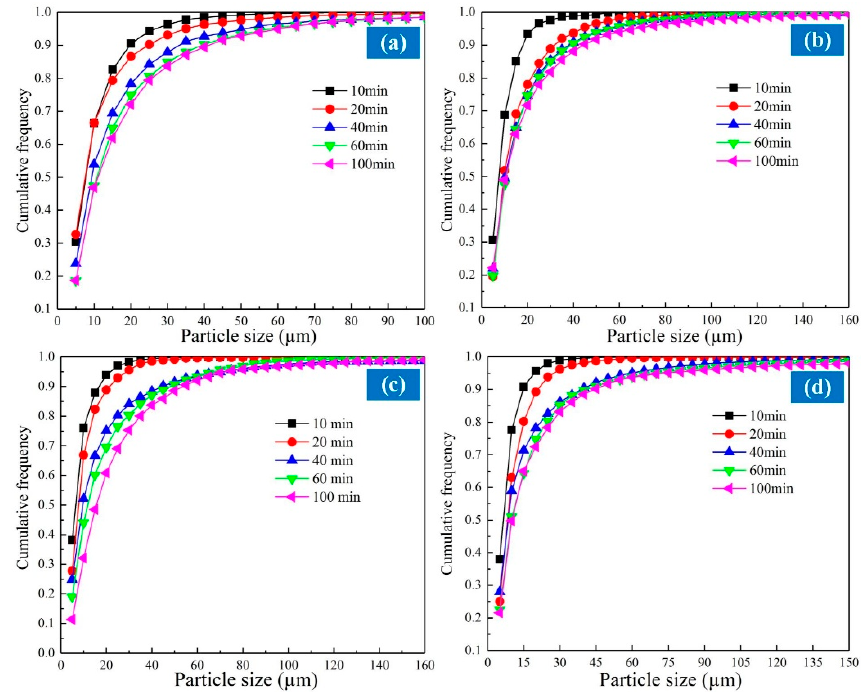
Figure 9. Cumulative size distribution of iron grain at different reduction temperature. ( a )1473 K ( b ) 1523 K ( c ) 1573 K ( d ) 1623 K.